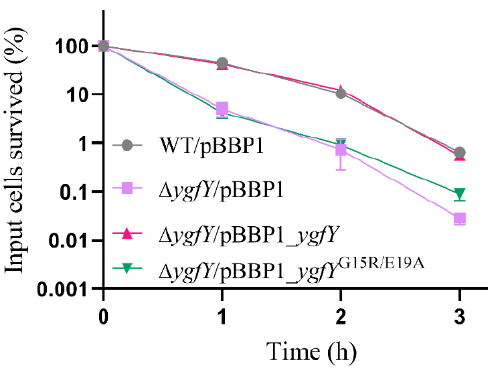
Figure 10. Nitrite tolerance of S. oneidensis MR-1. Cultures were exposed to 470 mM of nitrite for indicated time and then spotted on LB plates for cultivation and counting survived cells based on CFU. Percentage of survived cells are normalized by CFU in cultures before nitrite exposure (0 h). The data are the mean ± SD ( n = 3).